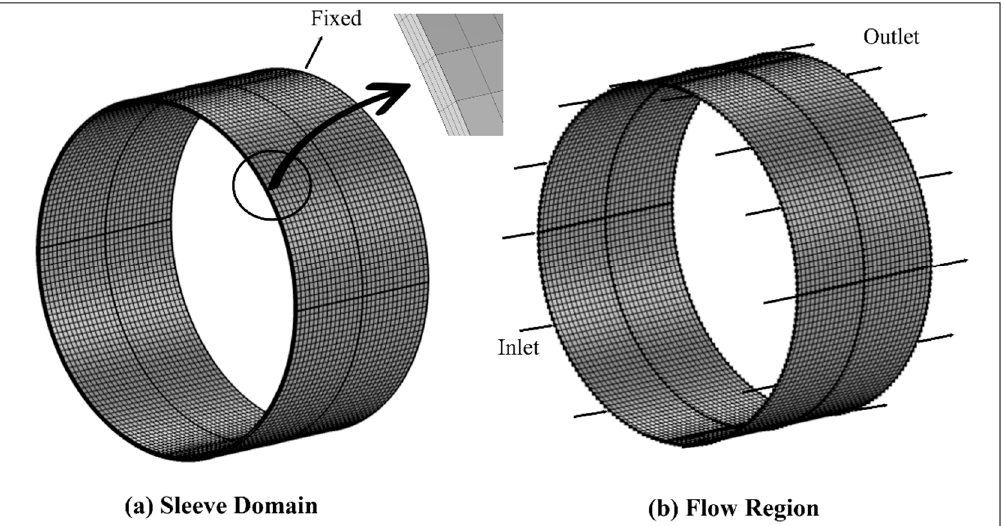
Figure 3. ( a ) Sleeve domain and ( b ) flow surface along with boundary conditions and meshing. The sleeve is fixed on the right end. The inner surface of the sleeve is subjected to pressure due to the fluid flow along the clearance, and the outer surface is subjected to uniformly distributed working pressure, which is equal to the inlet pressure ( P 0 ). The structural deformation of the sleeve reduces the clearance, which in turn affects the flow field, and thus, the resulting pressure distribution along the clearance. The clearance